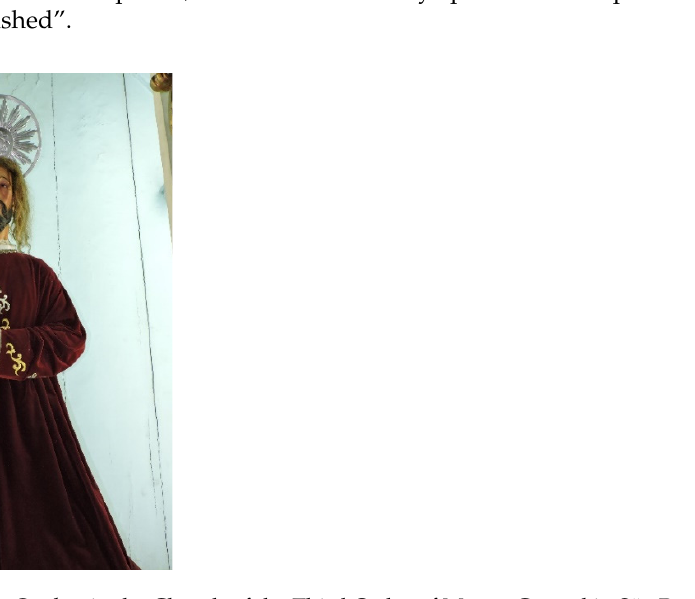
Figure 1. Agony in the Garden , in the Church of the Third Order of Mount Carmel in São Paulo. Polychrome wood sculpture (136 × 78 × 67 cm), eighteenth century. Photo by Lia Brusadin, 28 December 2016.